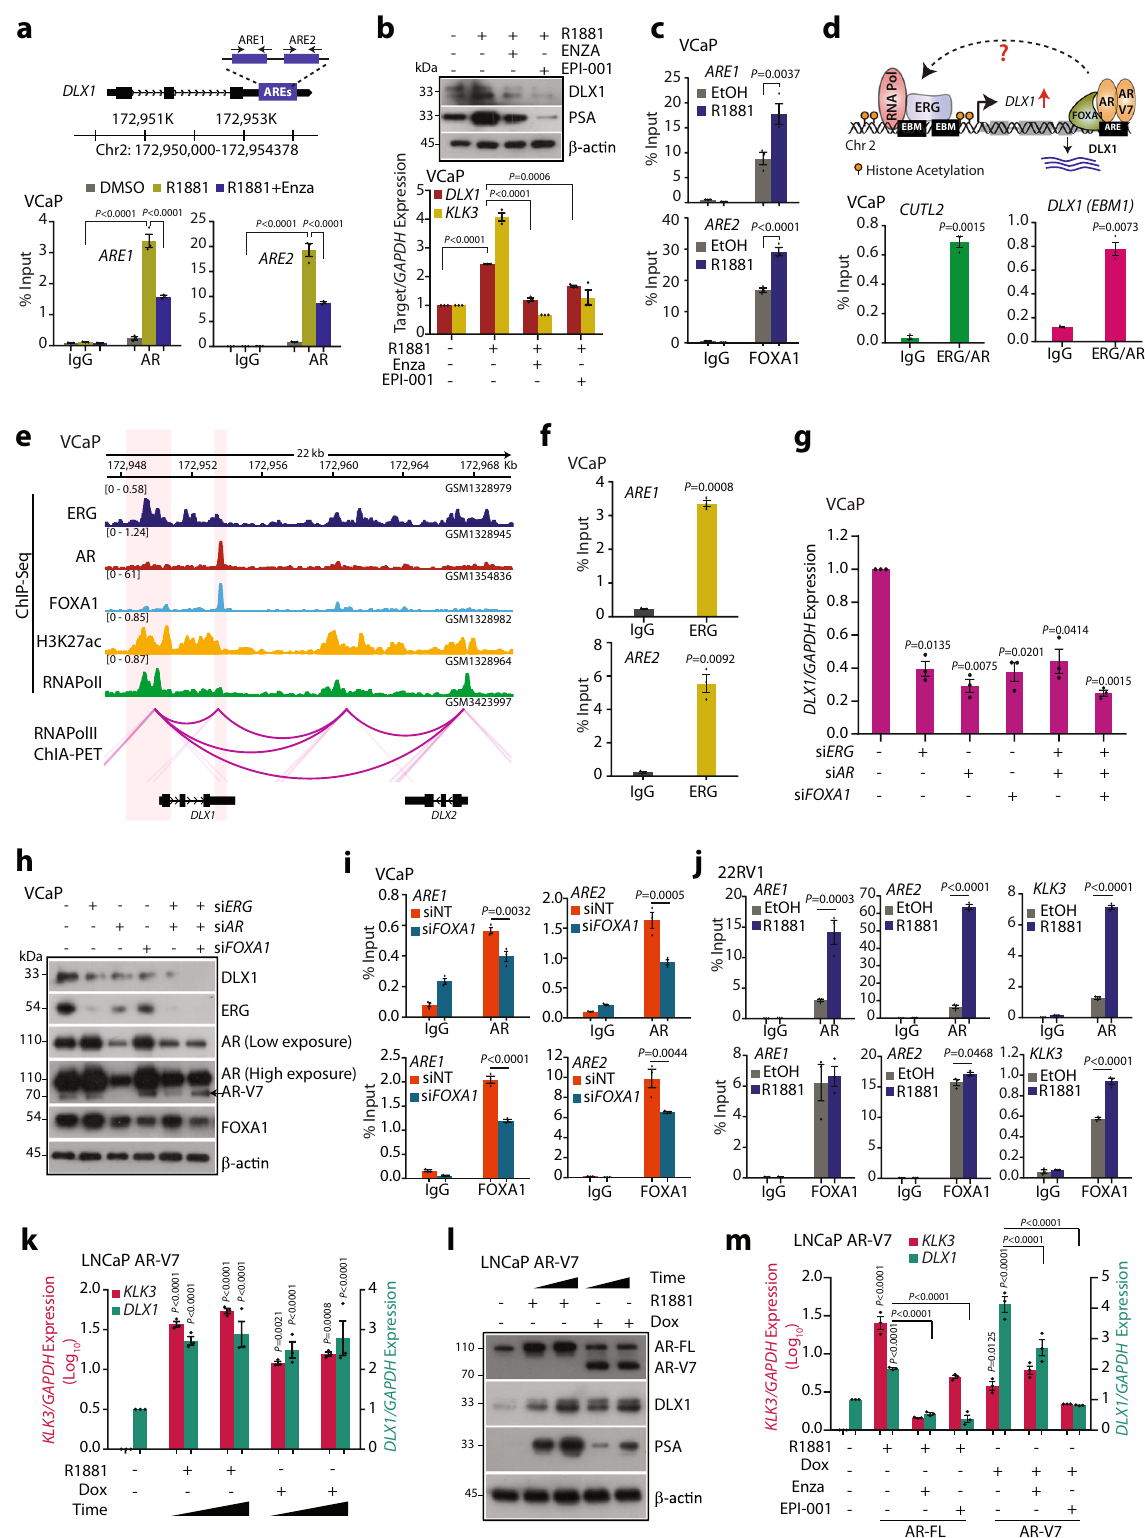
performed GSEA analysis of publicly available RNA-Seq data of JQ1 treated 22RV1 cells (GSE162564) using DLX1 putative target (Supplementary Fig. 3h) and observed enrichment of DLX1 target genes in control cells (Supplementary Fig. 6f). These data suggest downregulation of DLX1 putative target genes resulting in decreased oncogenic effect upon JQ1